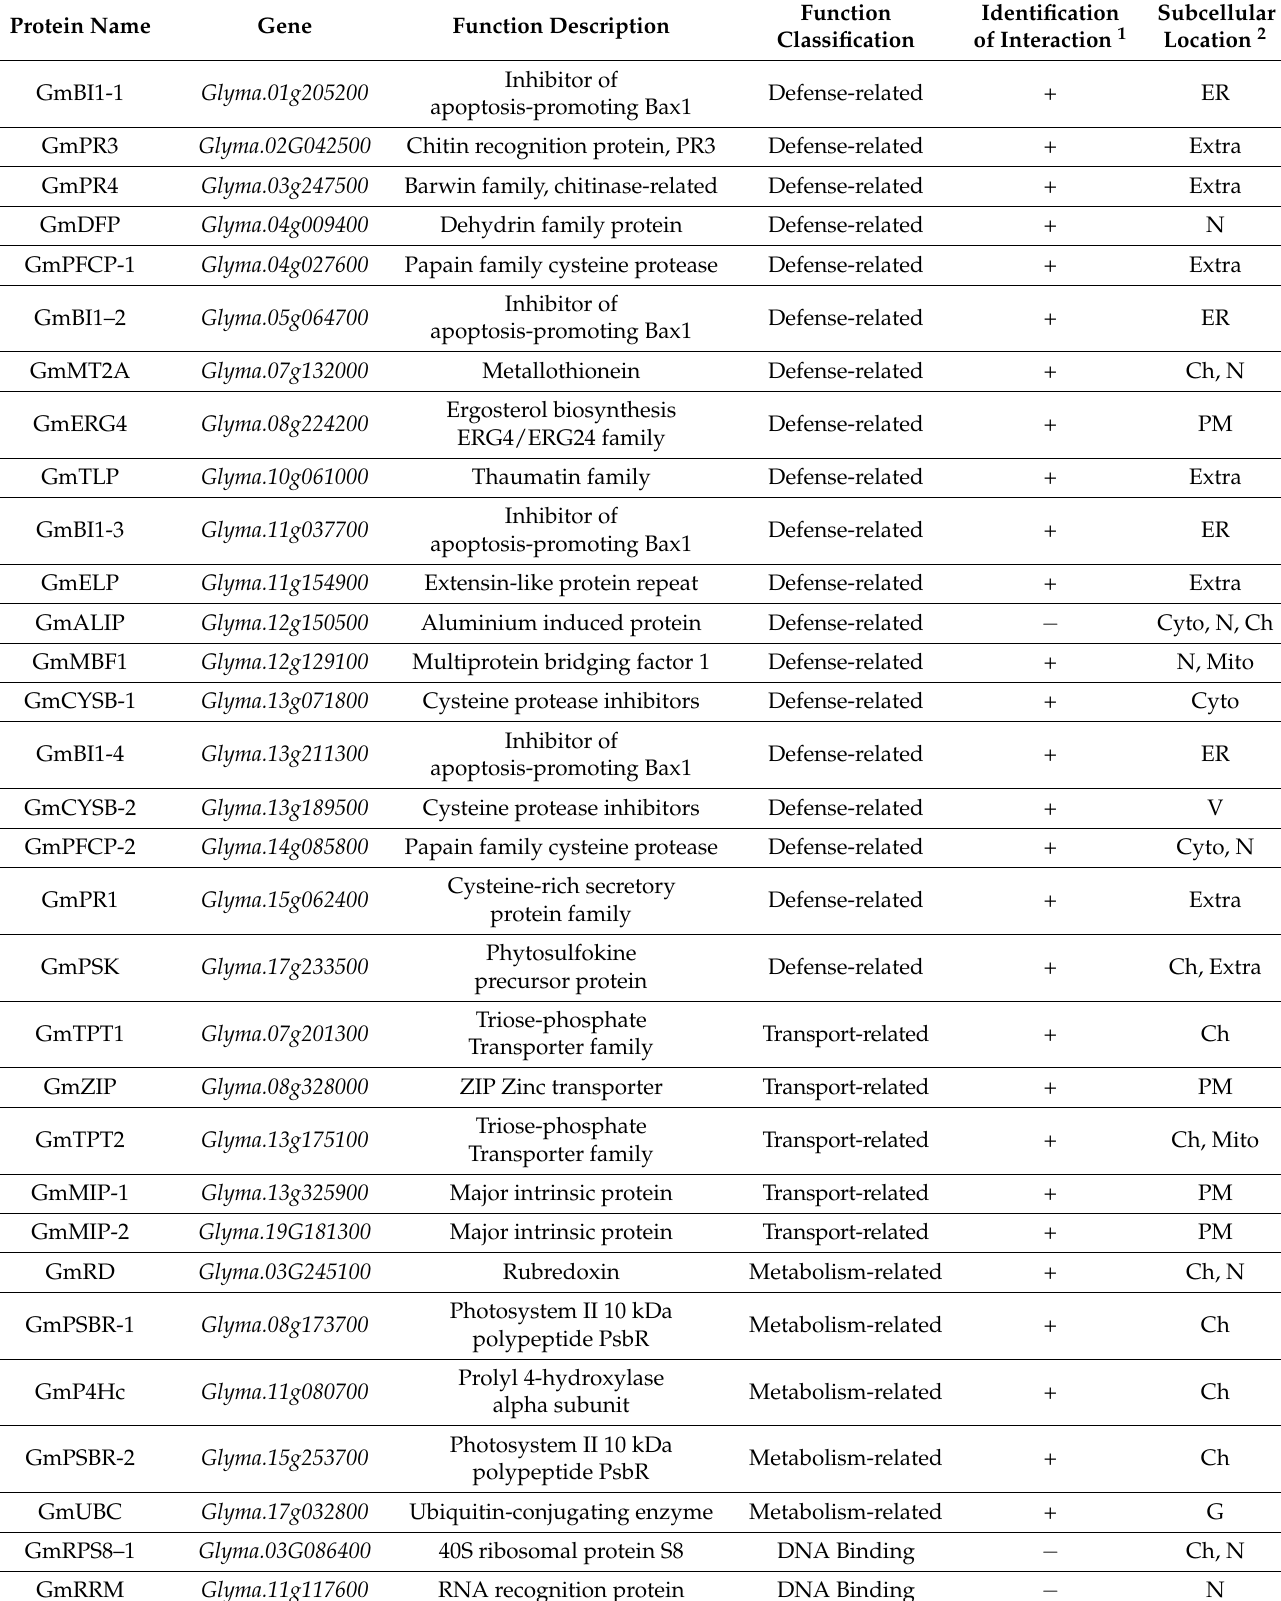
Table 1. Identification of proteins interacting with